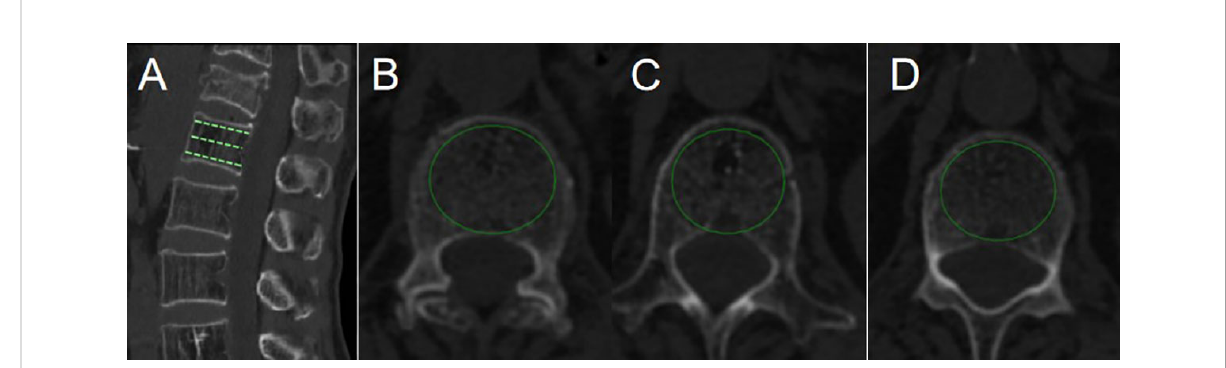
FIGURE 1 HU value was measured by PACS with the use of an elliptical region of interest function. (A) was a reconstructed CT sagittal image, marking the positions of the three slices. Slice (B) was chosen just inferior to the superior endplate. Slice (C) was taken in the middle of the body. Slice (D) was chosen just superior to the inferior